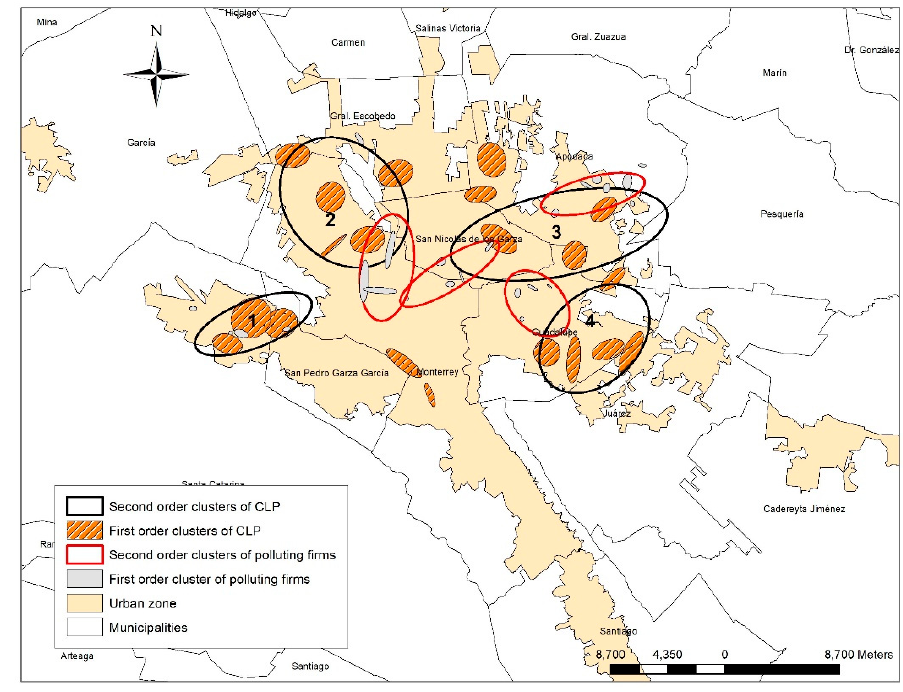
Figure 4. Spatial association of CLP and polluting industry.